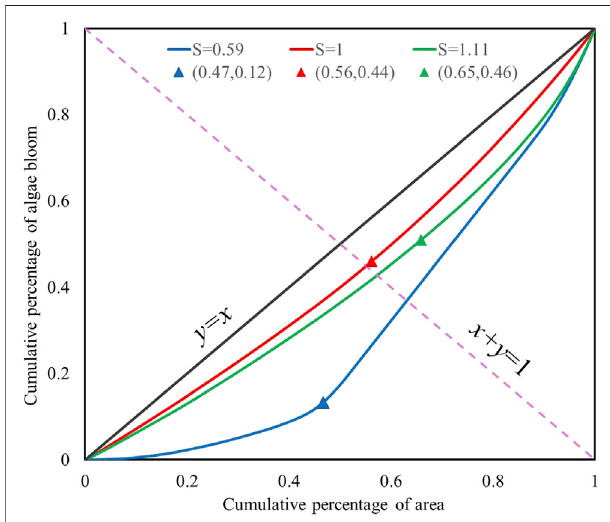
FIGURE6| ExamplesofLorenzcurveswithdifferentSvalues.Blue,red, and green colors indicate results for algal bloom distribution on 08/01/2020, 09/04/2014, and 10/31/2018, respectively.